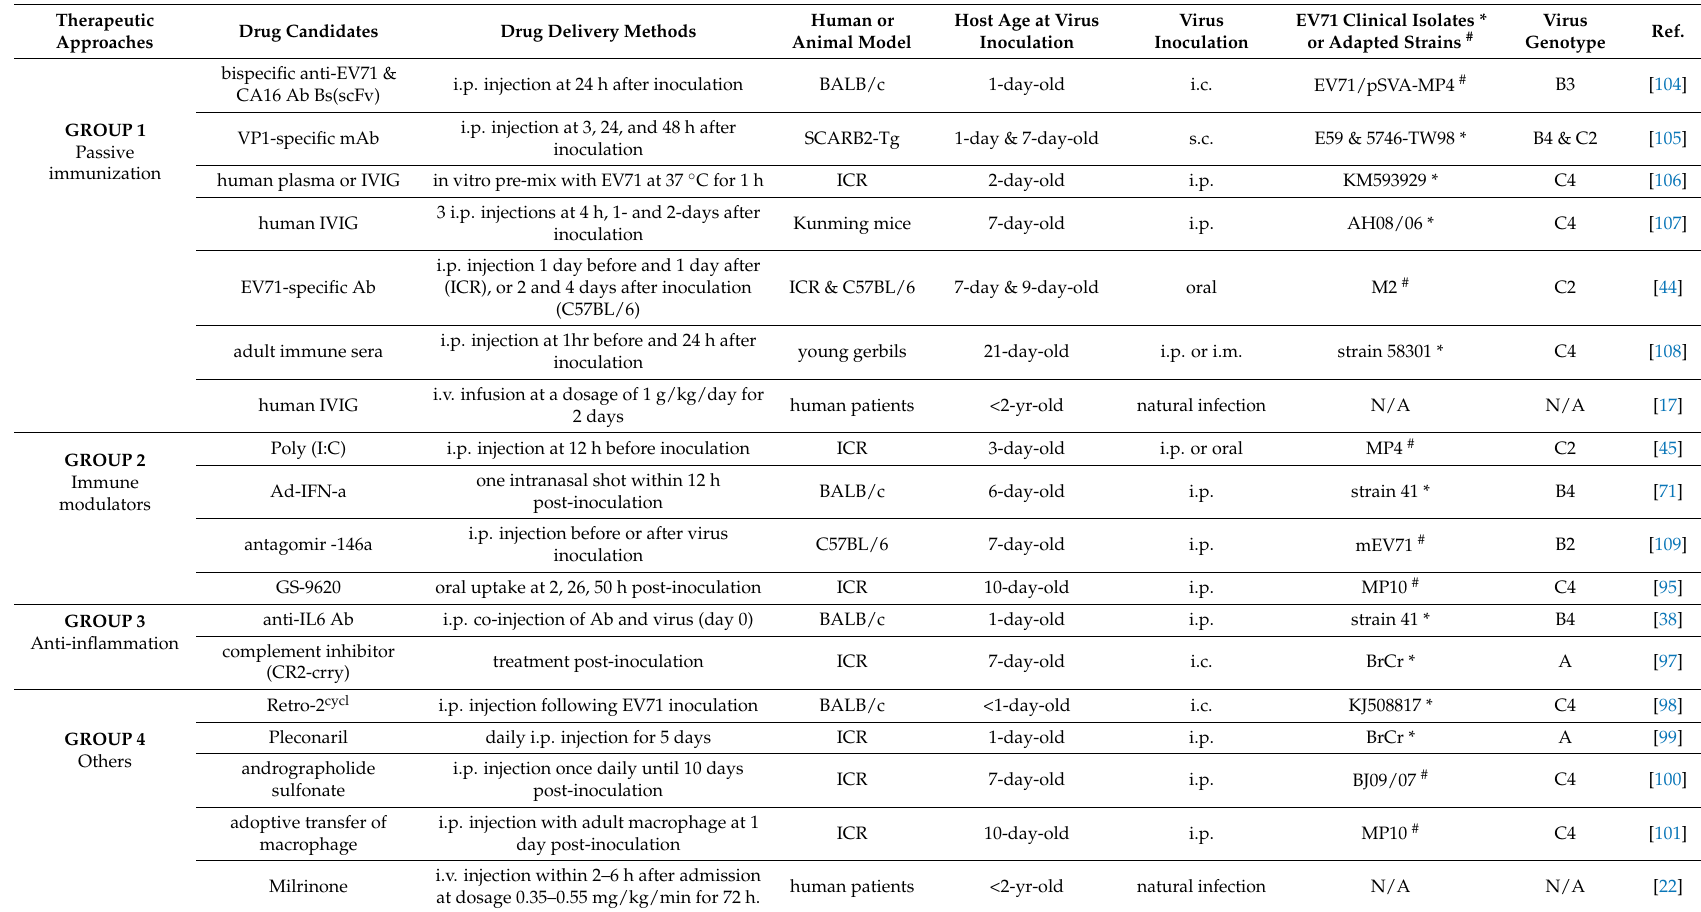
Table 4. Therapeutic compounds tested in animal models and human